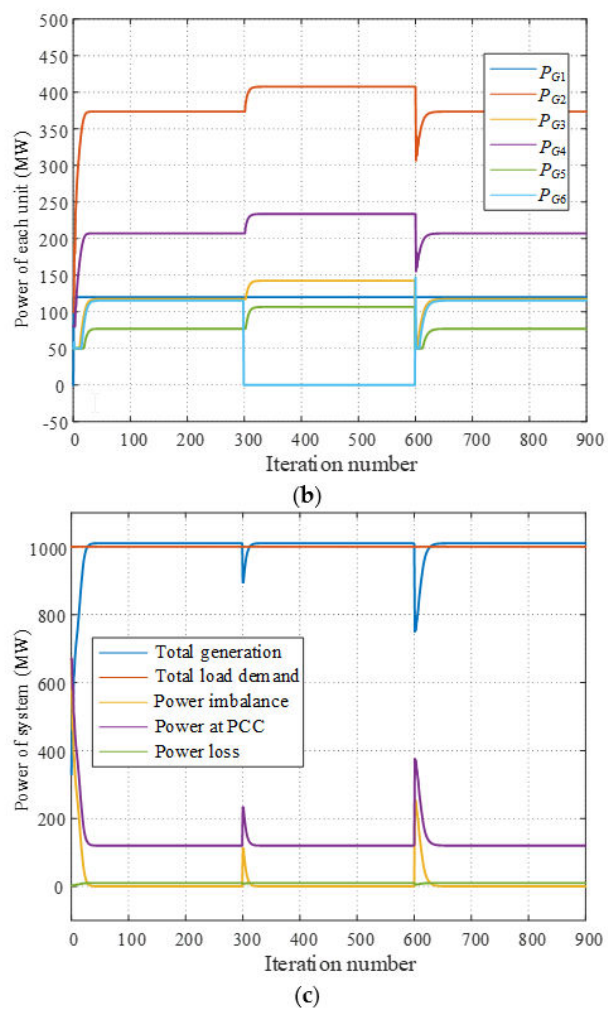
Figure 7. Simulation results of scenario 4. ( a ) Incremental cost; ( b ) power of each unit; ( c ) power information of the